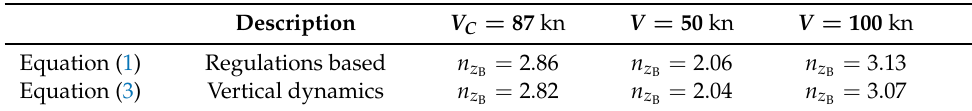
Table 2. Summary of results for the estimation of the limit gust load